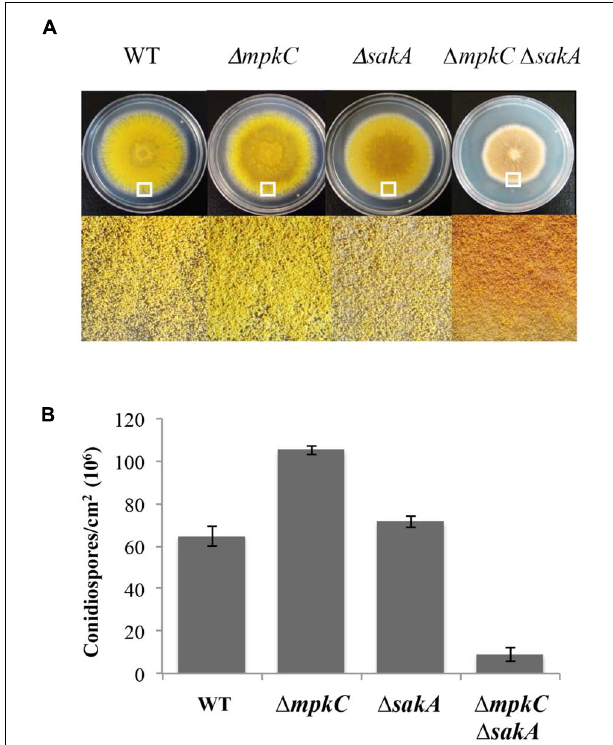
FIGURE 1 | sakA and mpkC deletion show opposing effects on conidiation but both genes are needed for normal conidiation. (A) Asexual spores (1 × 10 4 ) from strains CLK43 (WT), CFL10 ( (cid:49) mpkC ), TOL1 ( (cid:49) sakA ) and CFL12 ( (cid:49) mpkC (cid:49) sakA ) were inoculated on supplemented MM plates and incubated at 37 ◦ C during 5 days. (B) Total conidiospores per colony were harvested, counted, and the count divided by the colony area to obtain the number of conidiospores per square centimeter. Bars indicate standard deviation from three independent experiments. A representative experiment is shown. The white squares in panel (A) indicate the colony regions enlarged at the bottom of the figure. See Supplementary Table S1 for strain full